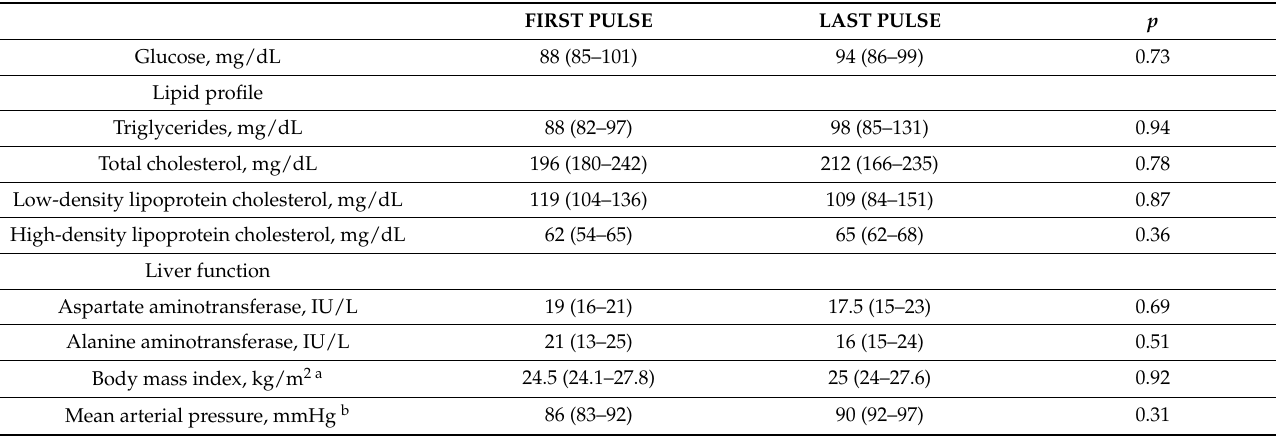
Table 3. Laboratory characteristics of patients with dysthyroid optic neuropathy before and after additional treatment with pulses of intravenous